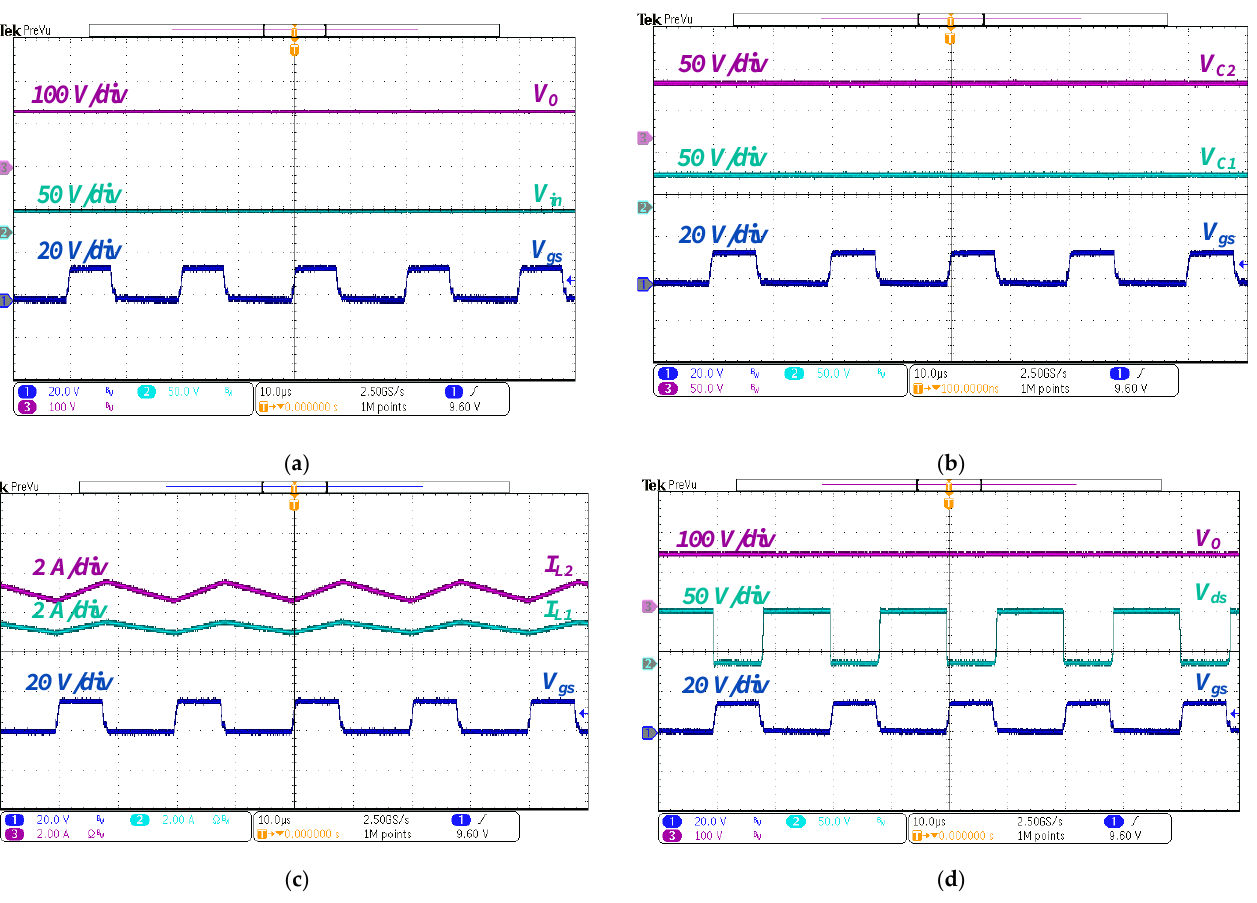
Figure 18. Related waveforms of the experimental results for proposed converter II. ( a ) Gating pulse, input voltage, and output voltage; ( b ) gating pulse, voltage for capacitor C 1 and C 2 ; ( c ) gating pulse, inductor current for L 1 and L 2 ; and ( d ) gating pulse, switch voltage, and output voltage.